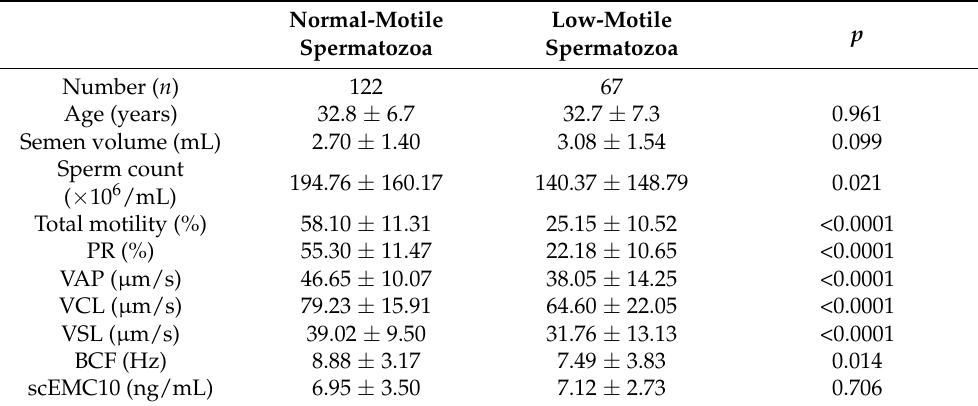
Table 1. Characteristic parameters of sperm samples in a cohort of Chinese participants.